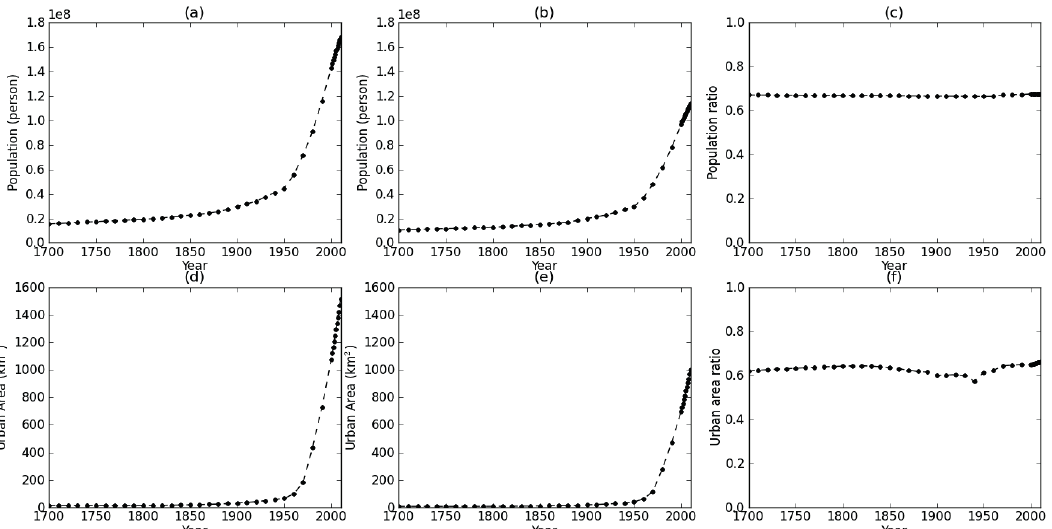
Fig. 2 Population and urban areas in Bangladesh from 1700 to 2010: (a) total population, (b) population in floodplain, (c) ratio of population (floodplain versus nation), (d) total urban area, (e) urban area in floodplain, and (f) ratio of urban area (floodplain versus